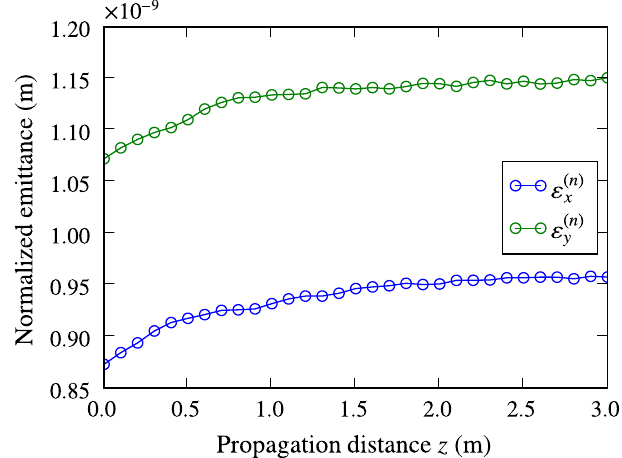
FIG. 12. Transverse emittances of the particle bunch as a function of propagated